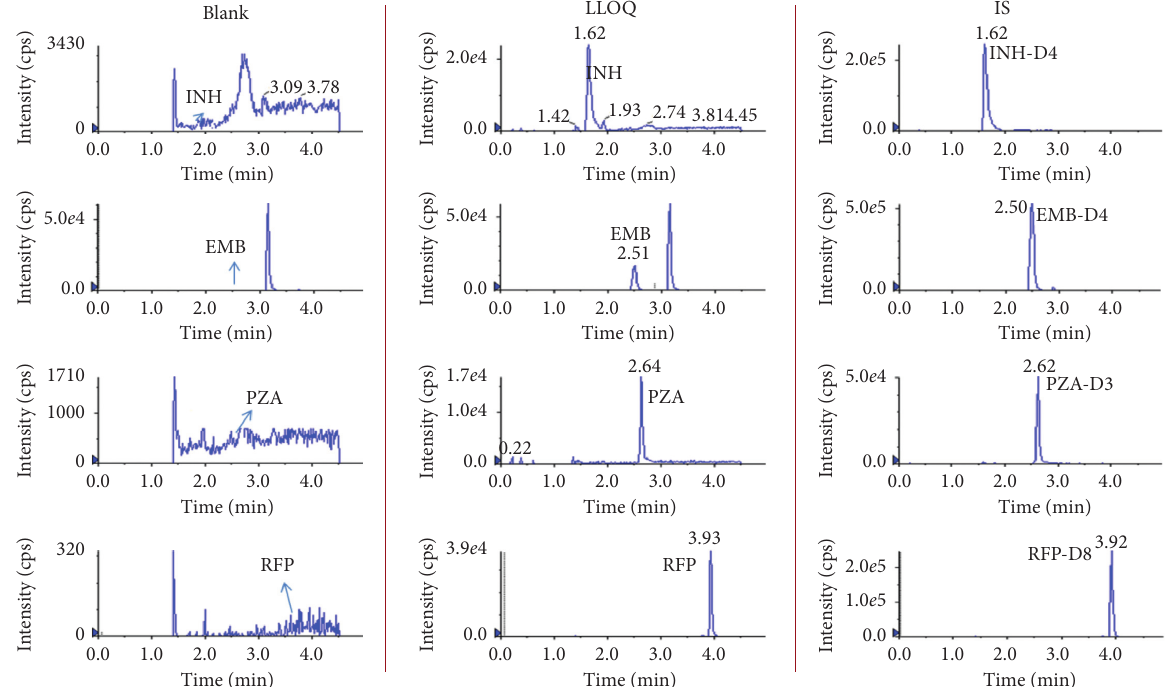
Figure 2: Chromatograms of blank human serum, LLOQ, and serum sample with ISs. Table 2: Regression equation, correlation coefficient, linearity range, and LLOQ of each analyte. Analytes